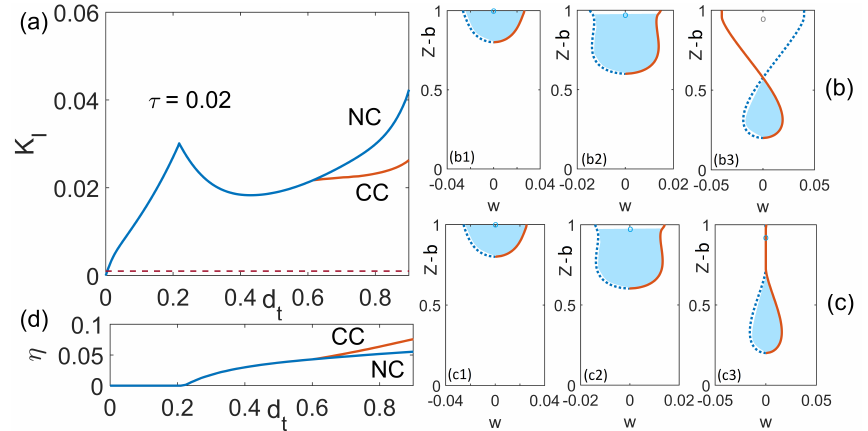
Figure 3. (a) Scaled stress intensity factor K I plotted against the crack length d t for scaled water volume, β = 0 . 01, and scaled extensional stress, τ = 0 . 02, with (blue) and without (orange) applying the contact condition, as indicated by CC and NC, respectively. (b, c) The corresponding crack width w(z) plotted against z for d t = 0 . 2 (b1, c1) , d t = 0 . 4 (b2, c2) and d t = 0 . 8 (b3, c3) , without (row b ) and with (row c ) the contact condition. The left-hand crack face is shown in dotted blue, the right in solid orange and water-filled parts of the crack in light blue. A circle indicates the “water level” (as defined by η ) even where the crack is closed. Note that the horizontal axis is scaled differently in each column for clarity. (d) The corresponding water level against crack length for the case shown in panel (a) .